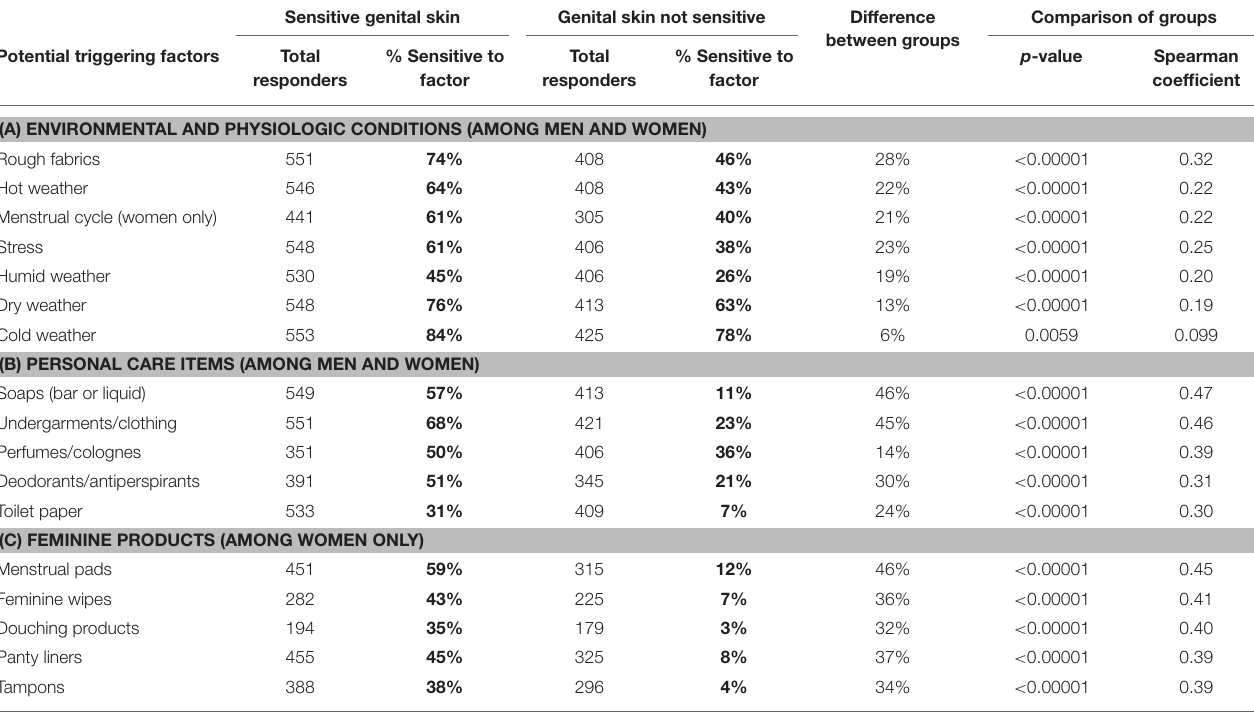
TABLE 2 | Perceptions about factors triggering skin responses among individuals claiming sensitive genital skin. Sensitive genital skin Genital skin not sensitive Difference